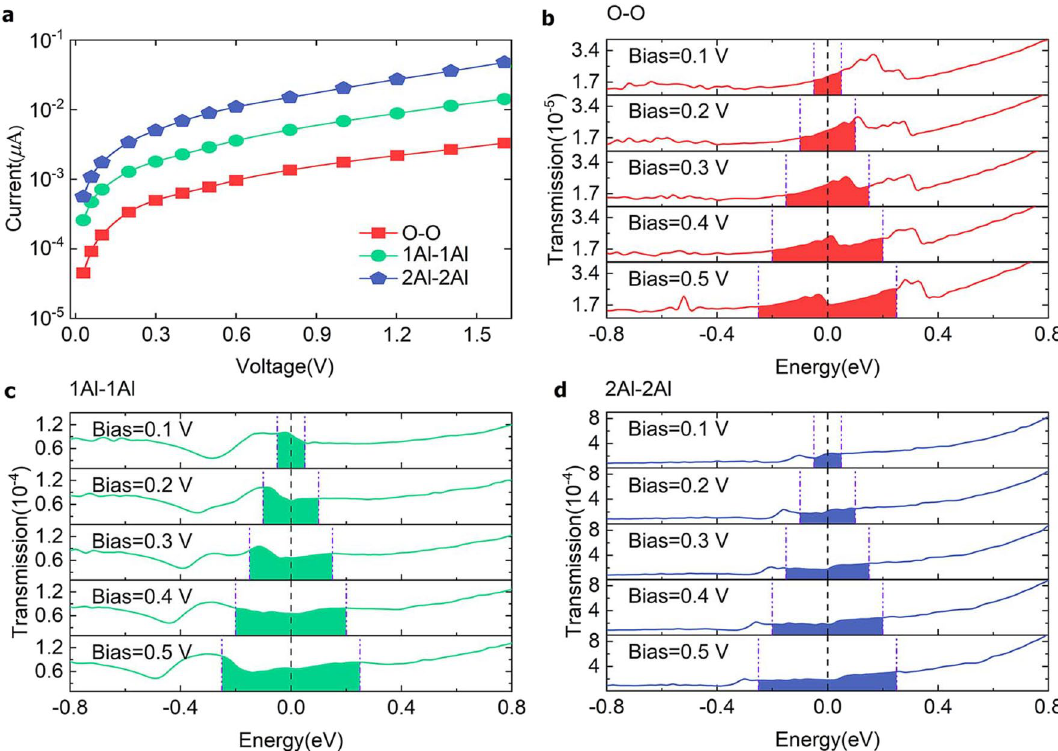
Figure 3. Current-voltage curves and transmission spectra of models with different termination modes at different bias voltages. ( a ) Current-voltage ( I − V ) curves of three calculated Al 2 O 3 termination mode device models. The red, green, and blue lines denote the O-terminated (O), Al-terminated(1Al), and 2Al-terminated (2Al) oxide layer models respectively. ( b ) Transmission spectra of O-terminated model. ( c ) Transmission spectra of Al-terminated model. ( d ) Transmission spectra of 2Al-terminated